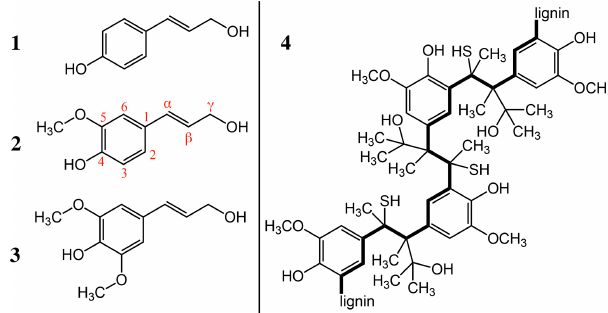
Figure 1. Main precursor monomers of lignin are the following: (1) p -coumaryl alcohol, (2) coniferyl alcohol and (3) sinapyl al- cohol. (4) An example of the polymeric structure provided by the supplier